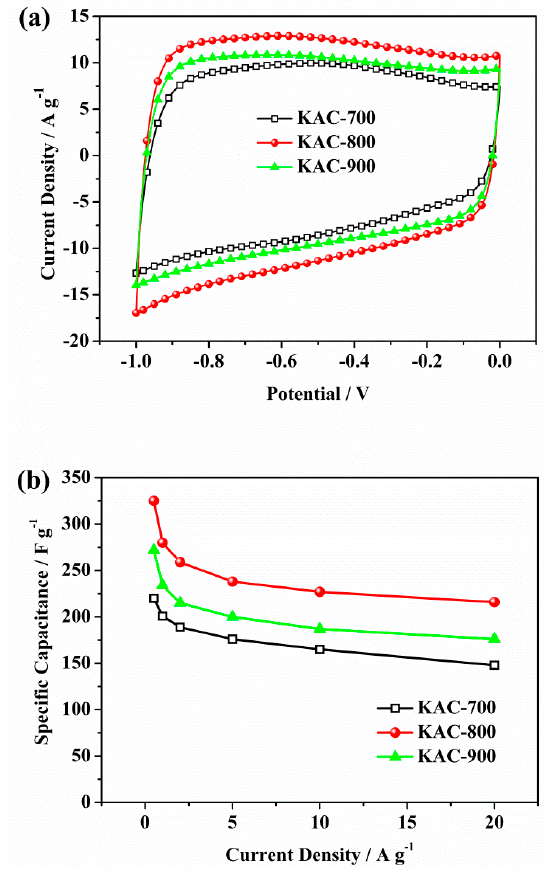
Figure 2. ( a ) CV curves of the porous carbons at the scan rate of 50 mV s − 1 ; ( b ) specific capacitances of porous carbons as a function of the current densities.